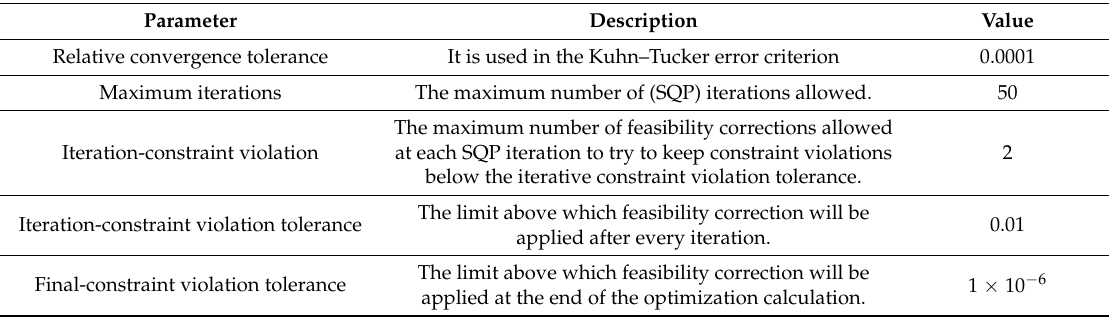
Table 4. Parameters of the optimization method (successive quadratic programming (SQP)).